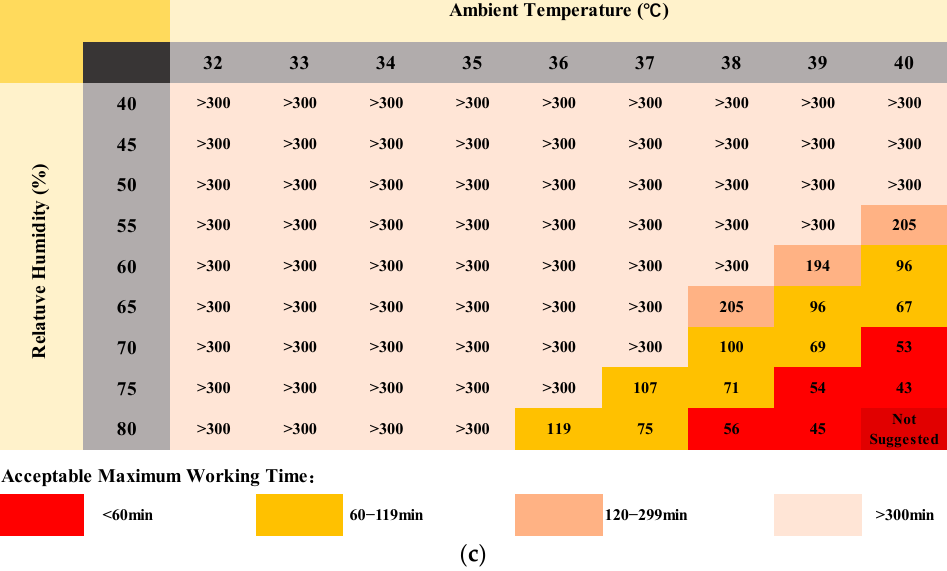
Figure 6. Charts of acceptable maximum working time (AMWT) for grid workers in different environments based on core temperature and sweat loss threshold: ( a ) without wind, ( b ) wind speed of 1 m/s, ( c ) wind speed of 2 m/s.